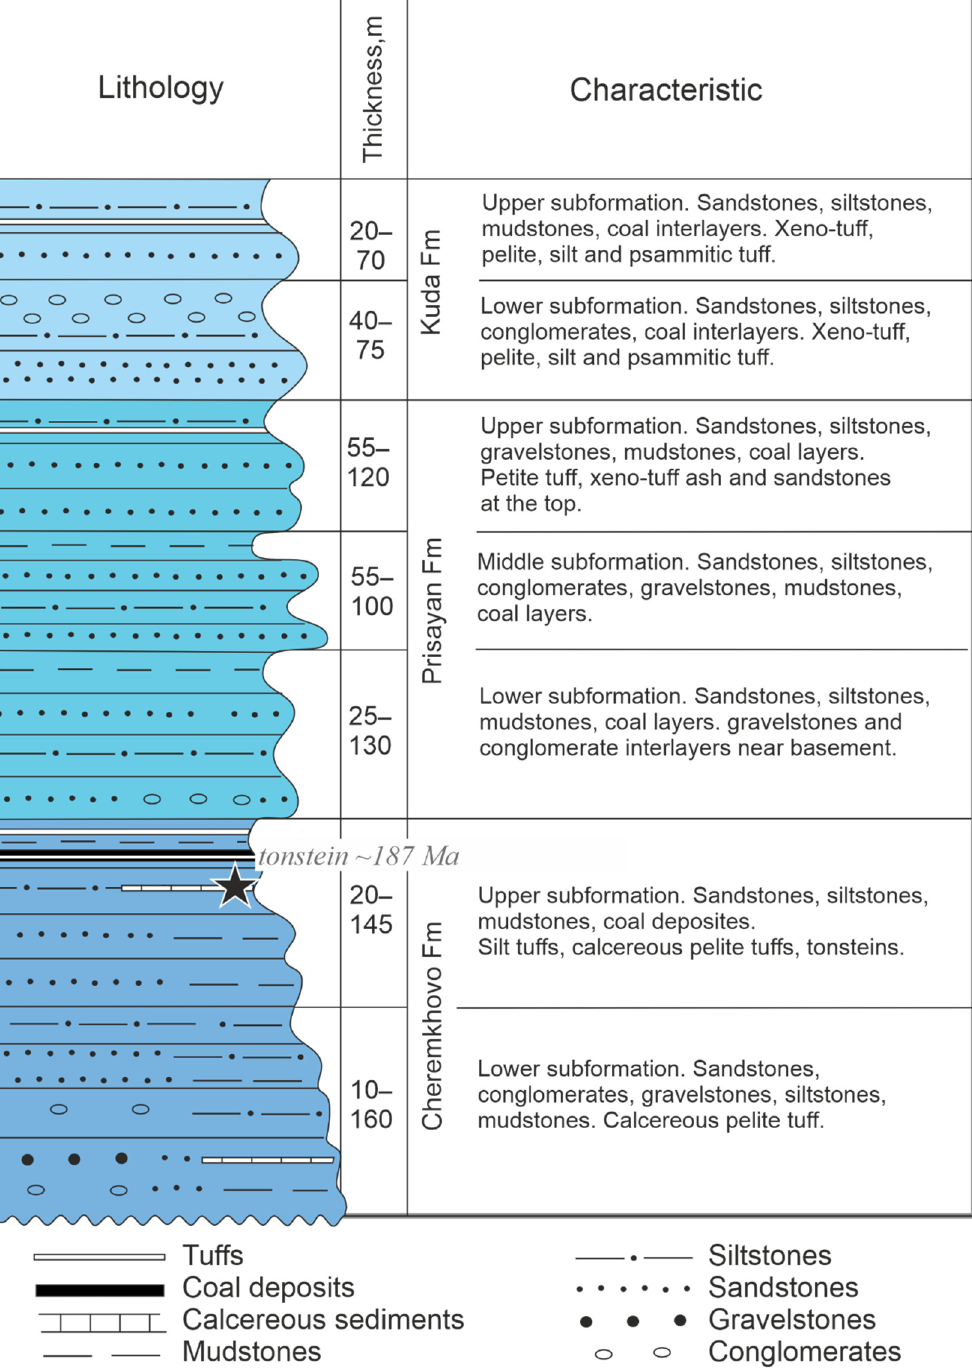
Figure 2. Lithology column of the Jurassic sediments of the Irkutsk coal-bearing basin. The black star marks the tonstein dated on zircon by U-Pb laser ablation inductively coupled plasma mass spectrometry (LA-ICP-MS) [6] .